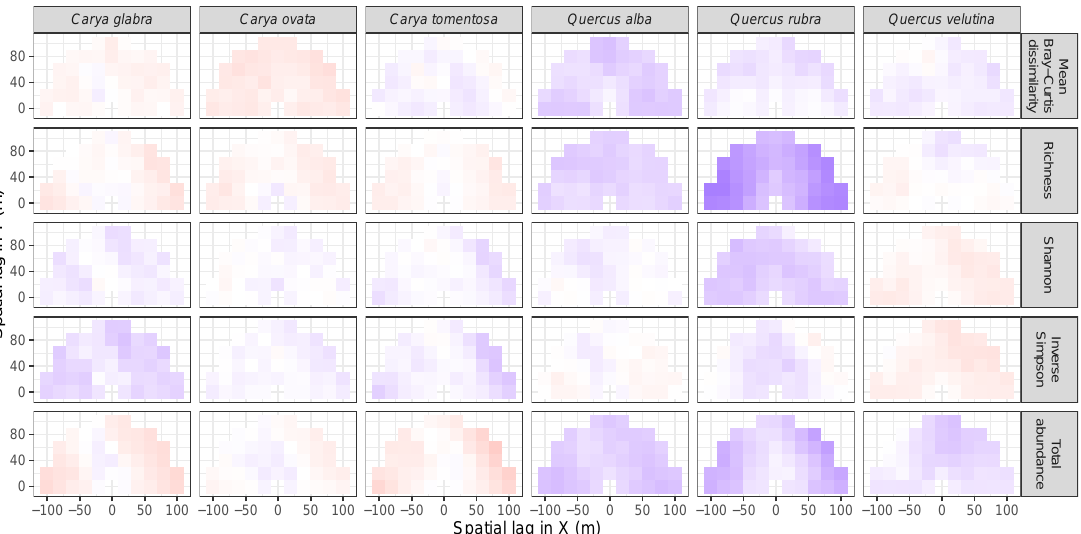
Figure 13. Codispersion between measures of diversity and total basal area of the six focal tree species in 20 × 20-m subplots in the 20-ha Tyson Research Center plot. Codispersion coefficients were calculated for spatial lags ranging from 0–150 m at 20-m intervals. The value of the codispersion coefficient can range from 1 (dark blue) through 0 (white) to 1 (dark red). Statistical significance of each codispersion coefficient is shown in Figure 14 and Figure A2. Summaries of codispersion values are given in Table A1).